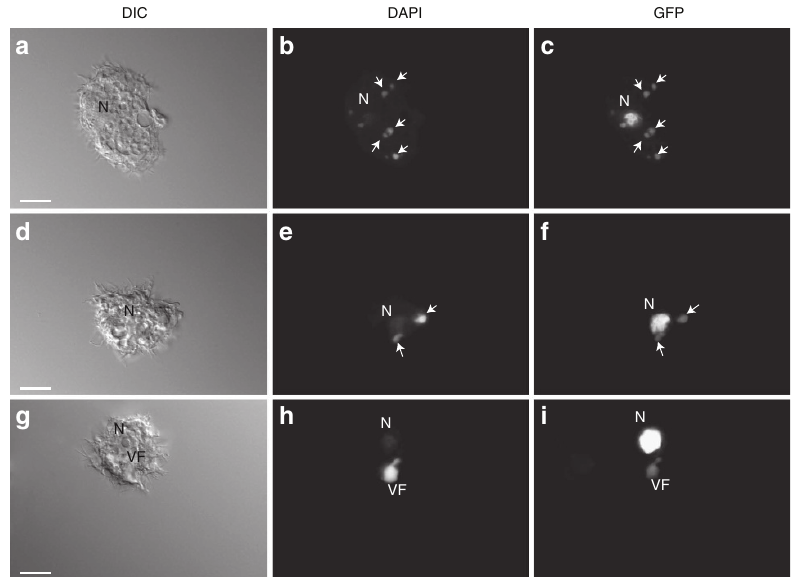
Figure 8 | Observation of A. castellanii cells expressing ML135-GFP infected by Noumeavirus between 2 and 3h pi. Cells were observed by interference contrast (DIC; scale bar, 10 m m) ( a , d , g ). DAPI-stained early nucleoids ( b , white arrows) and developing viral factories (VF, e , h ) produce intense fluorescence masking the DAPI staining at the nucleus (N). GFP staining co-localizes with the viral nucleoids ( c , white arrows) and the early VF ( f , white arrows). ( i ) In contrast with the strongly fluorescent nucleus, the mature VF is barely GFP stained. NATURE COMMUNICATIONS|8:15087|DOI: